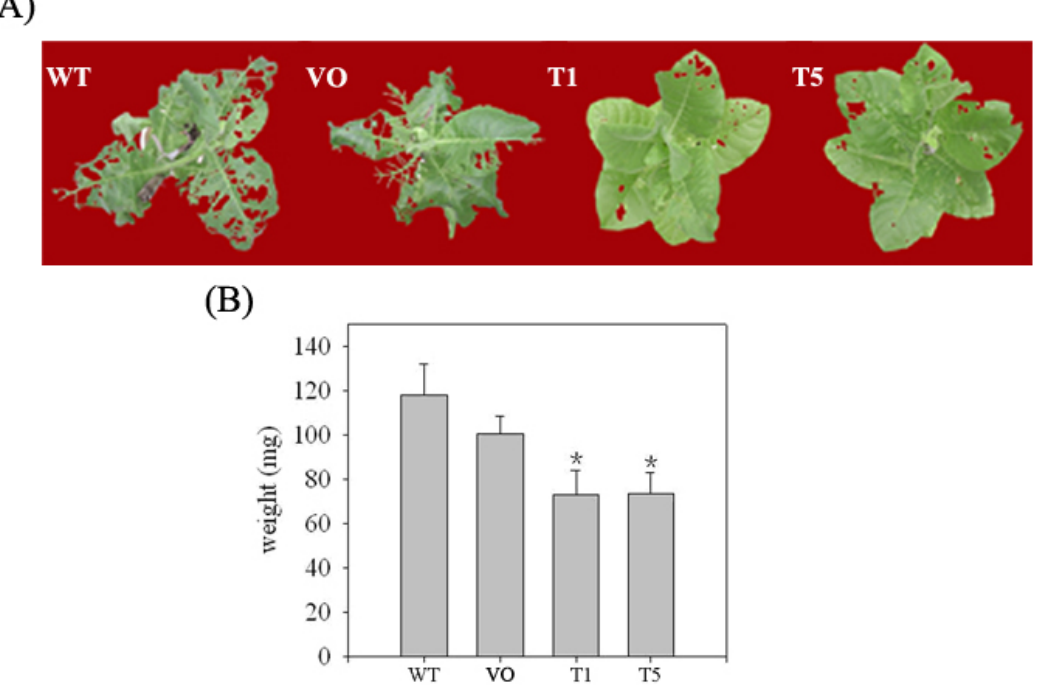
Figure 6. Insect bioassays of SaPIN2b-overexpressing transgenic plants. ( A ) Each tobacco plant was infected with 10 early second-instar H. armigera larvae for seven days. WT, wild-type plants; VO, vector-only transgenic plants; T1 and T5, SaPIN2b-overexpressing plants. ( B ) Weight of H. armigera fed on different tobacco lines. * indicates that p < 0.05. (The data were analyzed using the t -test).